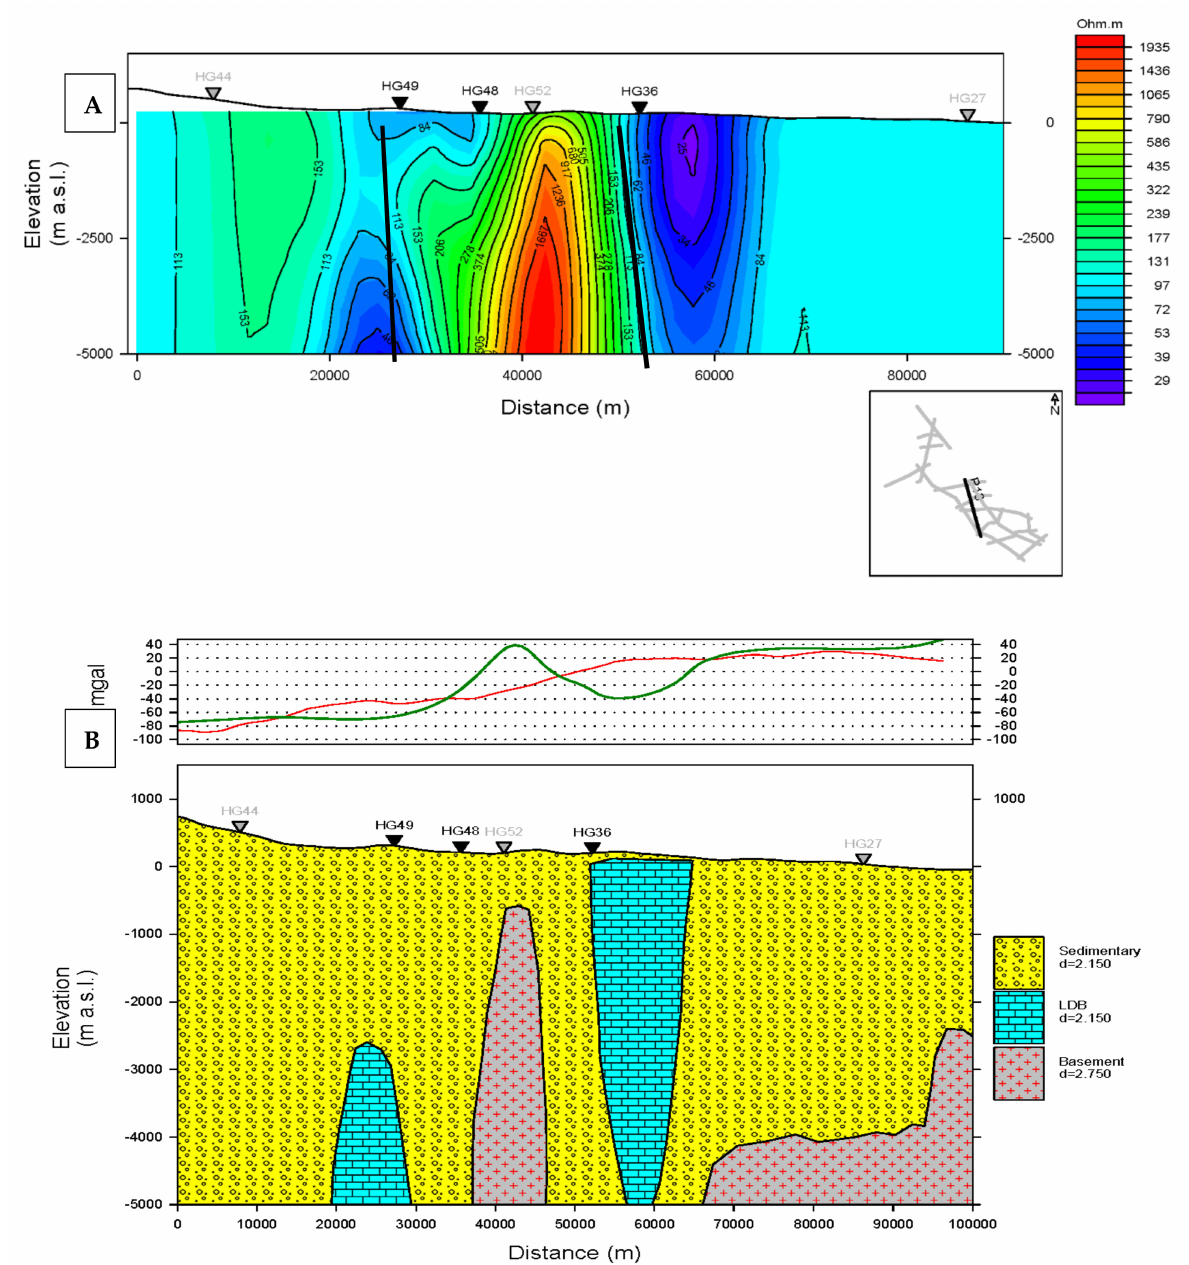
Figure 6. Profile-13 cross-sections derived from ( A ) 2D modeling of AMT data (upper panel) and ( B ) density modelling (lower